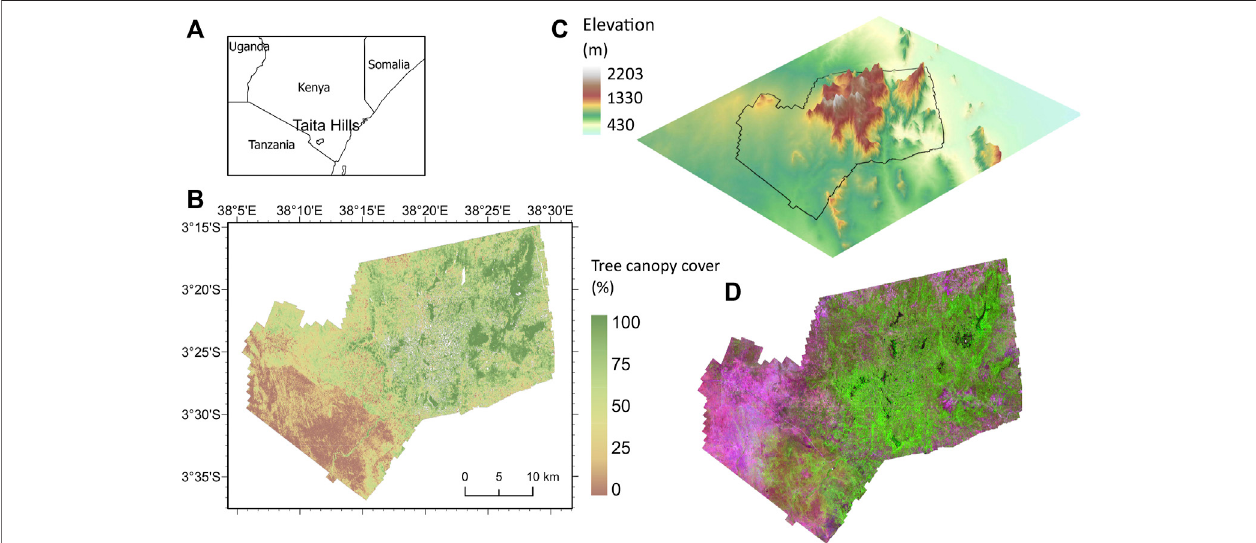
FIGURE 2 | Location of the study area with a map of tree canopy cover. (A) The area of interest (Taita Hills) located in Kenya; (B) Tree canopy cover map from the AirborneLaser Scanning datainTaita Hills; (C) 30 m digitalsurfacemodel(DSM)from theJapanAerospaceExplorationAgency(JAXA) inTaitaHills and (D) An example of Landsat 8 image acquired on 16 December 2015, displayed in R: SWIR1, G: NIR, B: red band.